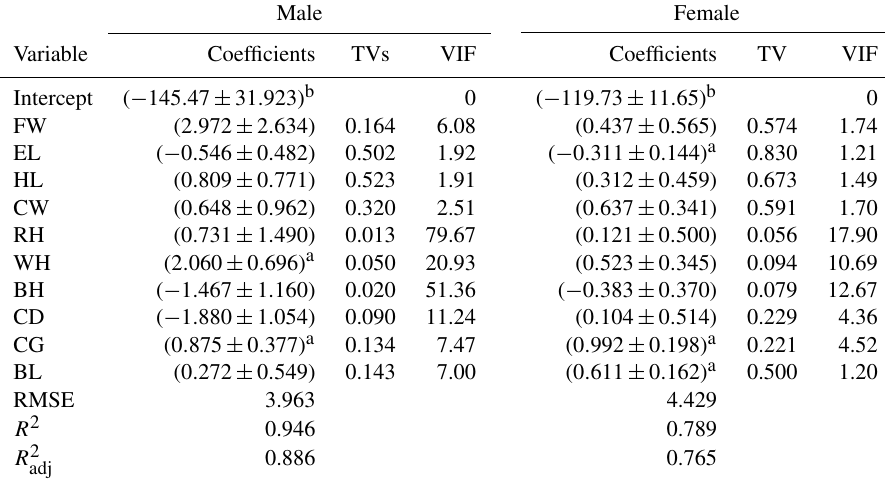
Table 2. OLS coefficients in multiple linear regression, tolerance, and VIF values for male and female goats.